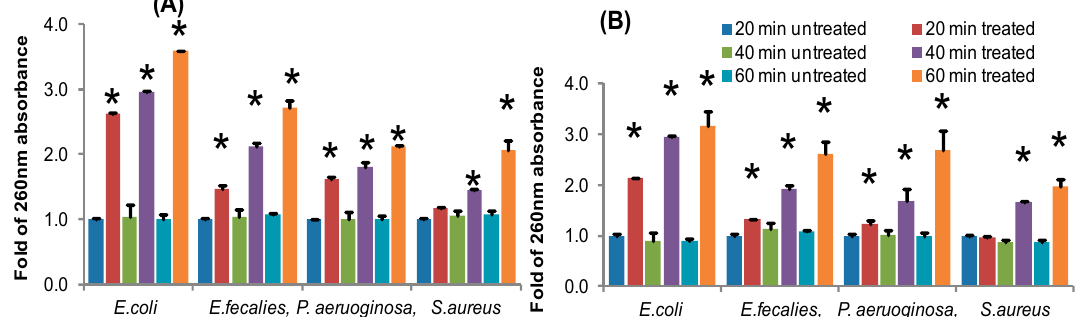
Figure 5. E ff ect of TC48 and TC50 on the release rate of 260 nm absorbing materials from pathogenic bacteria. ( A ) Fold of 260 nm absorbing materials releases by ECS of TC48 treated pathogenic bacteria; ( B ) fold of 260 nm absorbing materials releases by ECS of TC50 treated pathogenic bacteria. Data represent the mean ± STD ( n = 5), * Significance between treated and untreated groups at p < 0.05 level.